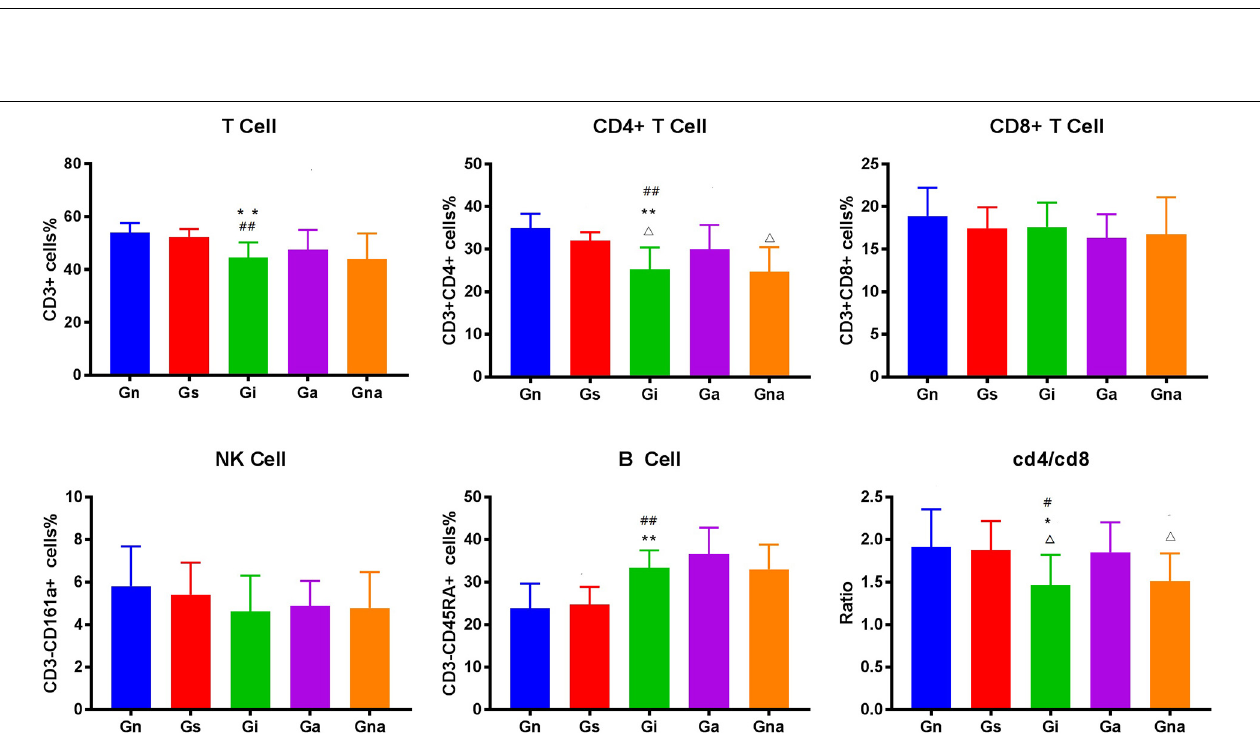
FIGURE 4 | Effect of acupuncture on peripheral blood lymphocyte subsets. The data are expressed as the mean ± SEM ( n = 10). ** P < 0.01, vs. Gn group; # P < 0.05, ## P < 0.01, vs. Gs group; (cid:77) P < 0.05, (cid:77)(cid:77) P < 0.01, vs. Ga group. Gn, normal group; Gs, sham-operated group; Gi, impaired group; Ga, acupoint group; Gna, non-acupoint group.